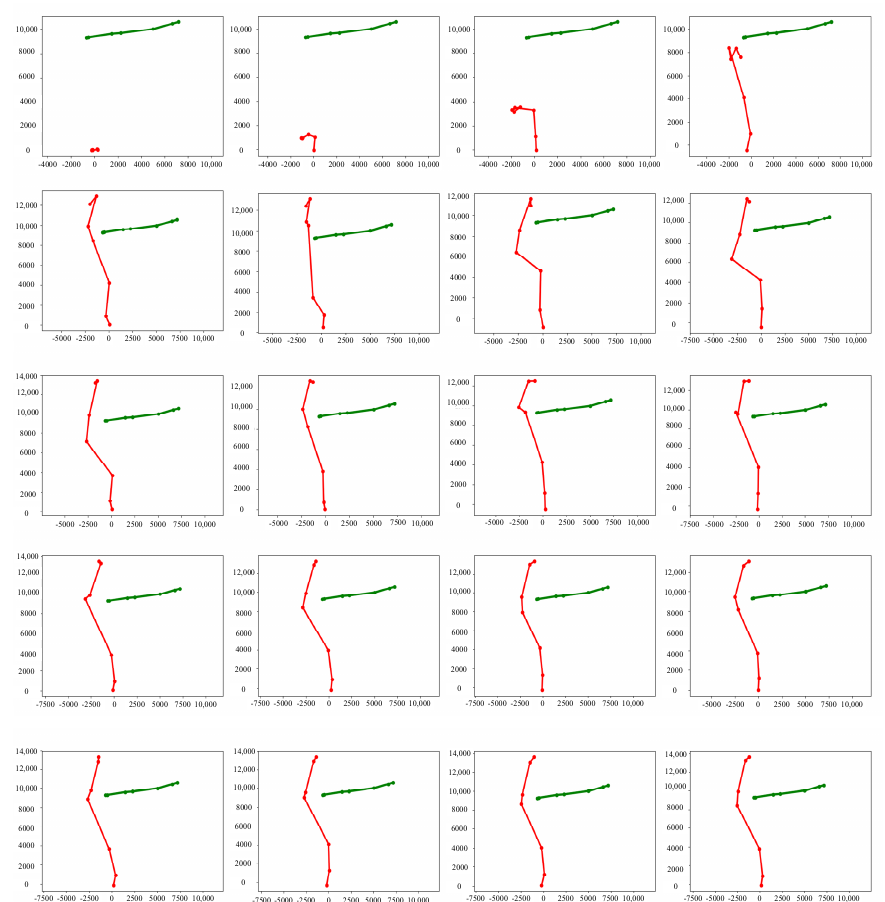
Figure 19. Training and learning processes of collision-avoidance decision-making.